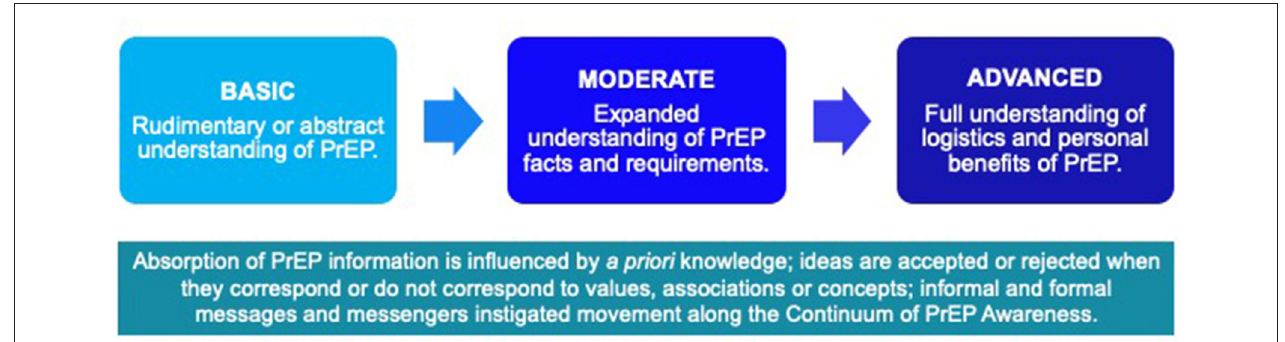
FIGURE 1 | Continuum of PrEP awareness: from abstract to personally